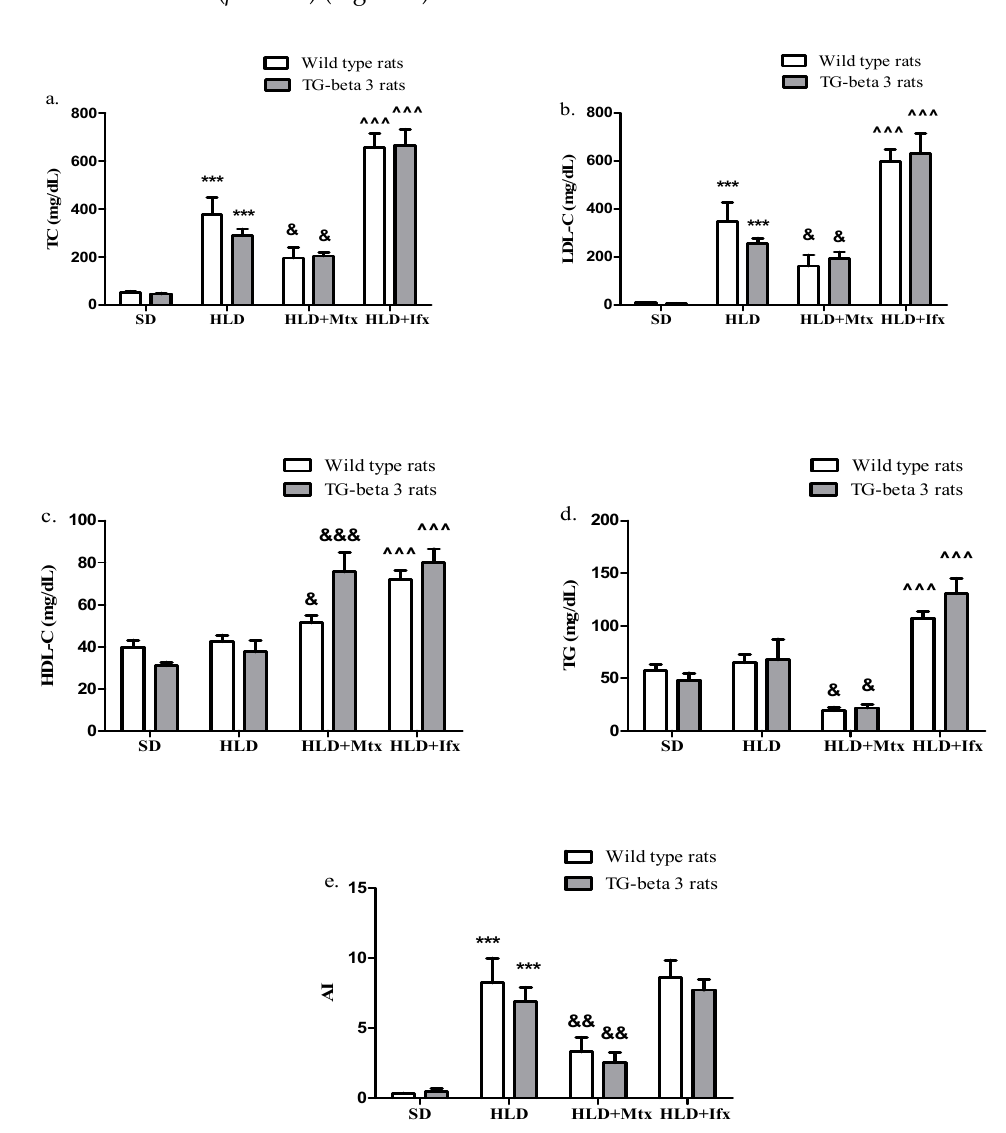
Figure 1. Methotrexate and infliximab effects on plasma lipid levels. ( a ) Total cholesterol (TC), ( b ) low-density lipoprotein cholesterol (LDL-C), ( c ) high-density lipoprotein cholesterol (HDL-C), ( d ) triglycerides (TG). ( e ) atherosclerosis index (AI). SD—standard diet; HLD—high lipid diet; Mtx-methotrexate; Ifx-infliximab; HLD + Mtx—high lipid diet associated with methotrexate; HLD + Ifx—high lipid diet associated with infliximab. *** p < 0.001 HLD versus SD group; & p < 0.05; && p < 0.01; &&& p < 0.001 HLD + Mtx versus HLD group; ^^^ p < 0001 HLD + Ifx versus HLD group.